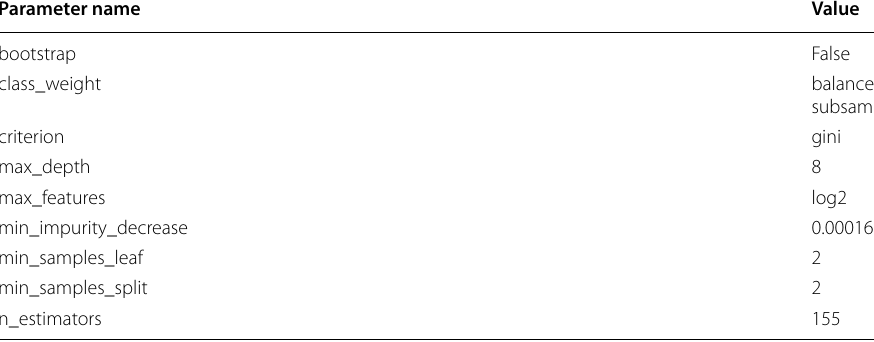
Table 68 Modes of RF tuned hyperparameter values for experiments with the information theft